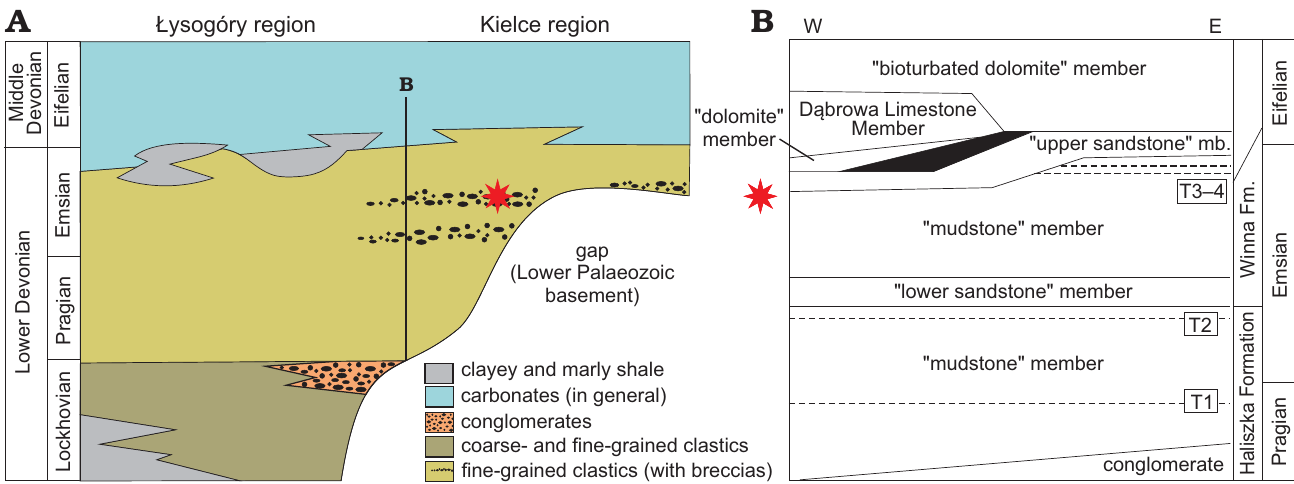
Fig. 2. A . Diagrammatic map the Holy Cross Mountains with indicated crossection from the base to the top of the Lower Devonian (modified after Szulczewski 1995). B . Lithostratigraphy of the upper Pragian to Eifelian in the Kielce Region (modified from Fija ł kowska-Mader and Malec 2011). Star indicates Pod ł azie Hill locality; T1–4, pyroclastic horizons; black area in B is a stratigraphical